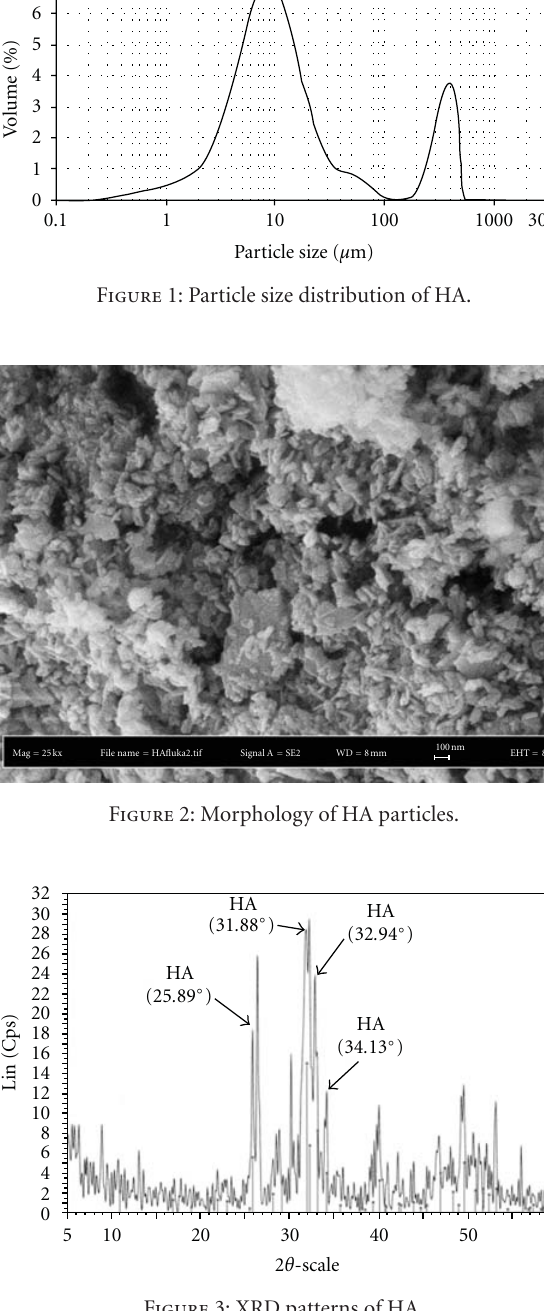
Figure 3: XRD patterns of